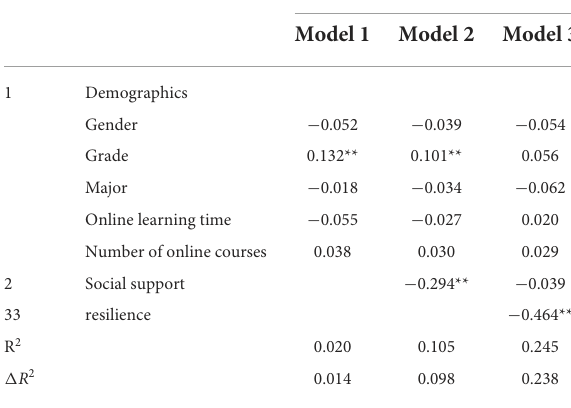
TABLE 7 Hierarchical linear regression analysis (social support as